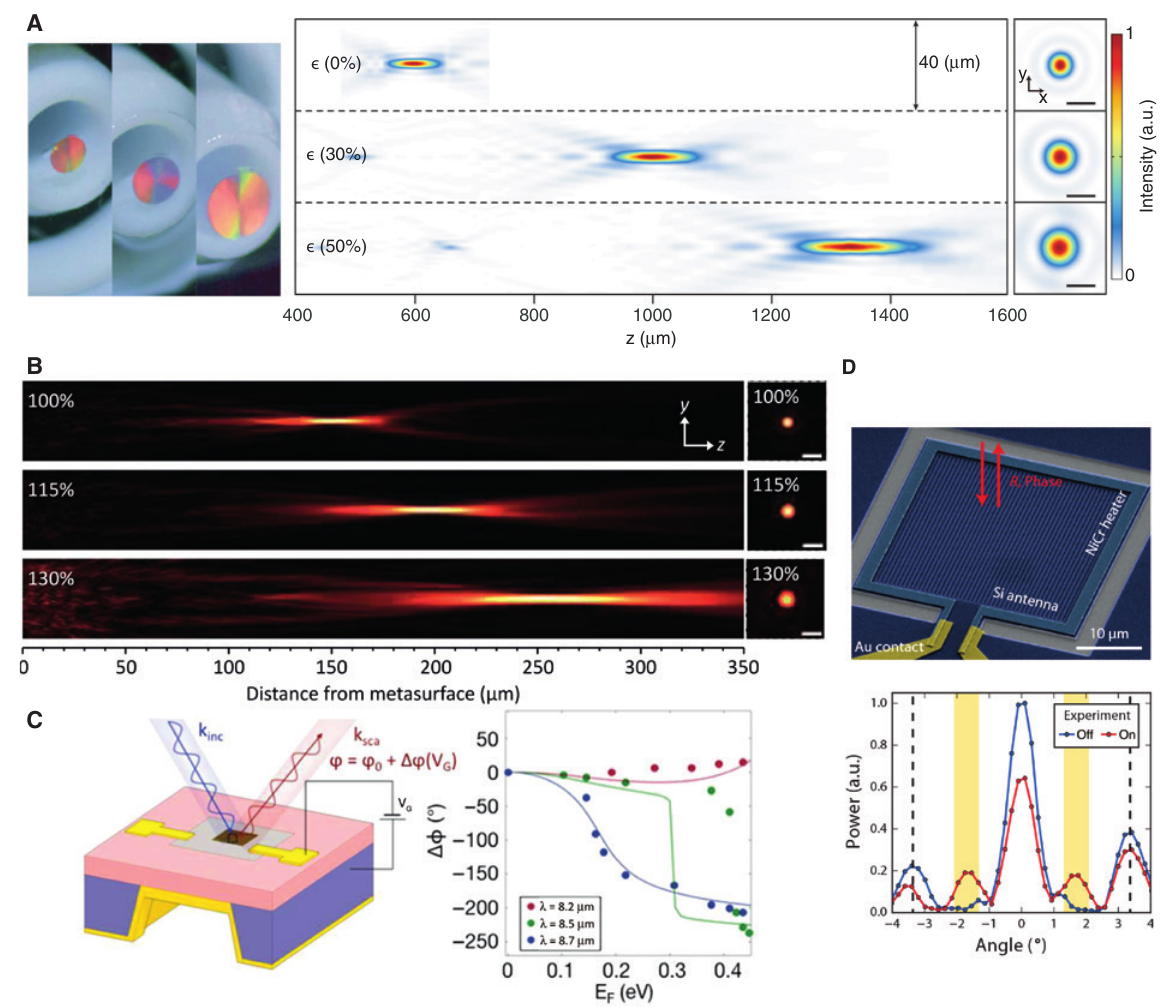
Figure 9: Tunable metasurfaces. (A) Highly tunable dielectric metasurfaces based on elastic substrates. Optical images of the tunable elastic metasurface at three different strain values are shown on the left. Measured intensity profiles of the varifocal lens at different strain values in the axial plane and the focal plane are shown on the right [42]. (B) Varifocal lens based on a plasmonic metasurface embedded in an elastic substrate. Measured optical intensity profiles of the elastic metasurface at different strain values in the axial plane (left) and at the corresponding focal planes (right) [246]. (C) Phase modulation of the reflected light through gate-tunable metasurfaces. A schematic of the tunable device is shown on the left. Reflected light phase modulations for three adjacent wavelengths are shown on the right [250]. (D) Phase-dominant SLM through thermo-optical effects in a one-sided cavity. A false-color scanning electron microscope image of the fabricated single-pixel of the tunable device is shown on the